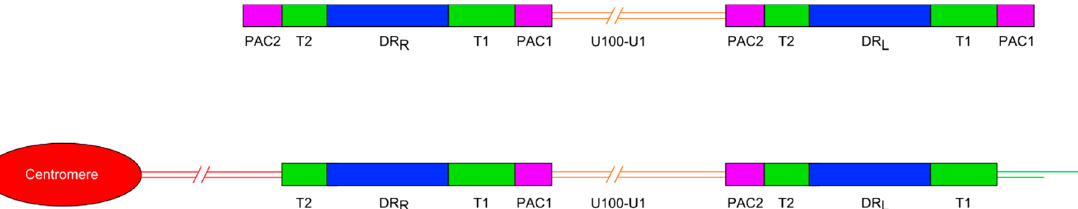
Figure 1. Diagram showing the general organisation of the HHV-6A and HHV-6B genomes. Upper panel shows the organisation of the non-integrated linear DNA genome of HHV-6A or -6B. The lower panel shows the loss of the terminal packaging sequences 1 and 2 (PAC1 and PAC2) following chromosomal integration in a telomere. DR L and DR R : Direct repeat regions; T1 and T2: Variable length telomere-like repeat regions.